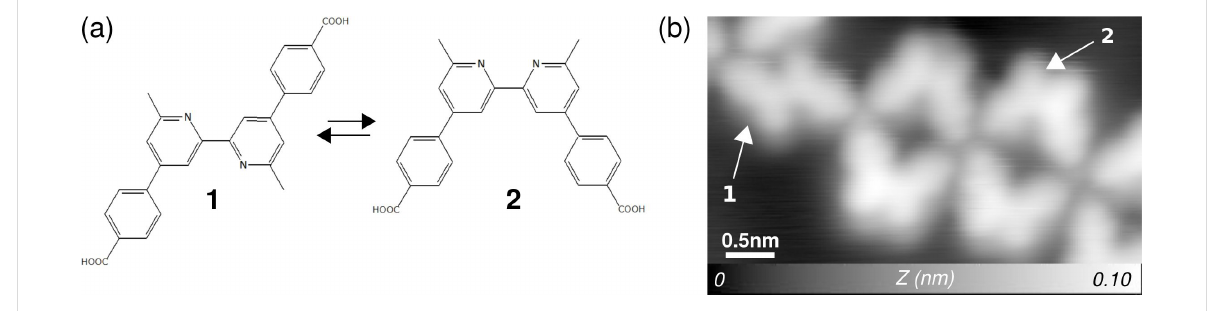
Figure 9: Example of a change of conformation potentially triggered at surfaces. a) Trans ( 1 ) and cis ( 2 ) isomers. By depositing and/or annealing, the molecule can be turned from trans to cis and vice versa. b) After the deposition of Fe atoms, the molecules can be switched from trans into cis confor-